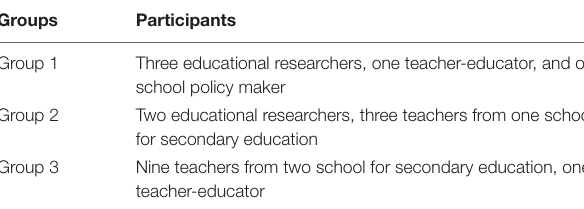
TABLE 1 | Participants expert